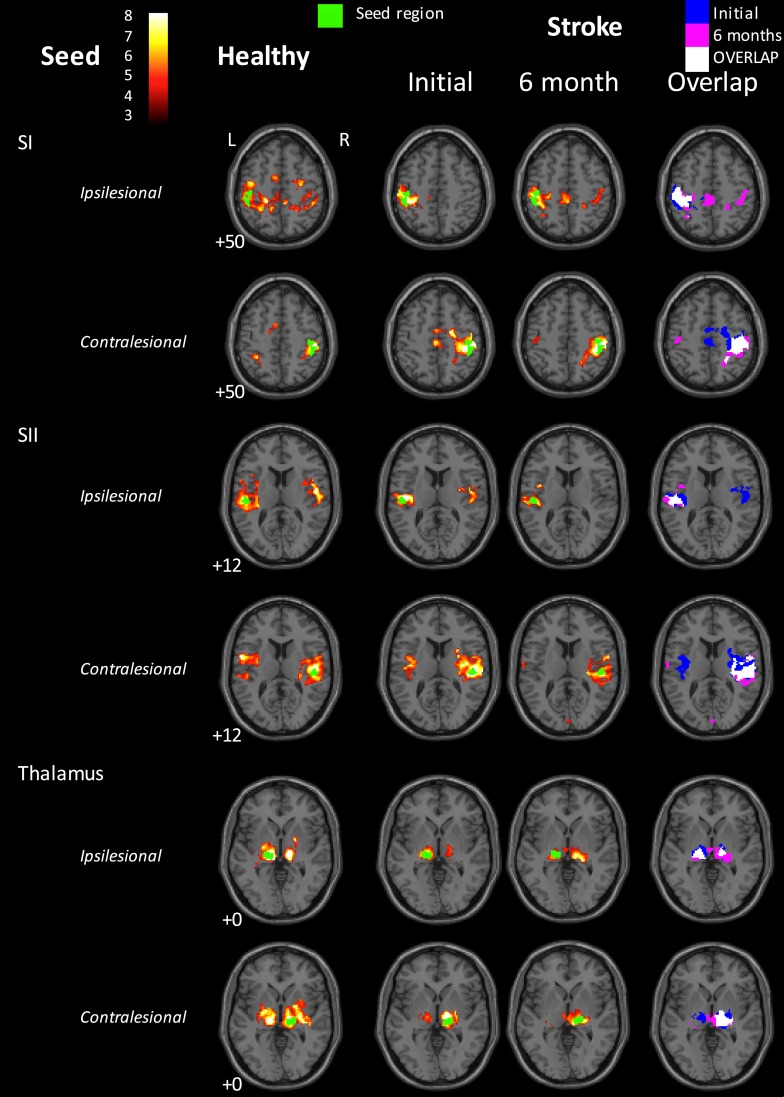
Functional connectivity maps for the healthy control group and for the stroke group at the 1- and 6-month time points. Left three columns: group-level functional connectivity maps. Right-hand column: overlaps of binarized group-level functional connectivity maps for the stroke group at the two time points. Blue = 1-month time point; Red = 6-month time point; Yellow = overlap. The stroke group appears to show disrupted interhemispheric functional connectivity for the SI seeds at 1 month post-stroke, relative to healthy controls. Some return of interhemispheric functional connectivity can be seen at 6 months. In contrast, interhemispheric SII connectivity in the stroke group appeared greater at 1 month than at 6 months post-stroke. The seed region is indicated in green. Images are displayed in neurological convention (subject’s left is displayed on image left). The left hemisphere represents the ipsilesional hemisphere – images of patients with right hemisphere lesions were flipped such that all infarcts are represented in the left hemisphere. Healthy controls were individually matched and images flipped accordingly. Slice numbers represent axial slice position in Montreal Neurological Institute (MNI) space. Color scale represents Z-values of group functional connectivity maps. SI, primary somatosensory cortex; SII, secondary somatosensory cortex. Analyses are based on contrast maps with an individual voxel height threshold level of p < 0.001. Results are displayed for significant clusters with p < 0.05 (false discovery rate, FDR, corrected).